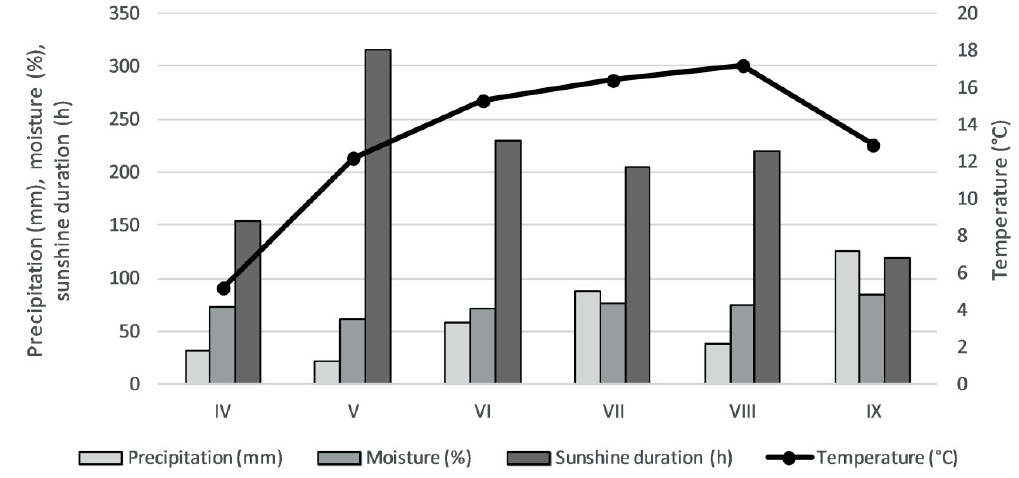
Figure 1a. Cultivation conditions of tested lingonberries (dynamics of meteorological factors). Figure A1. Cultivation conditions of tested lingonberries (dynamics of meteorological